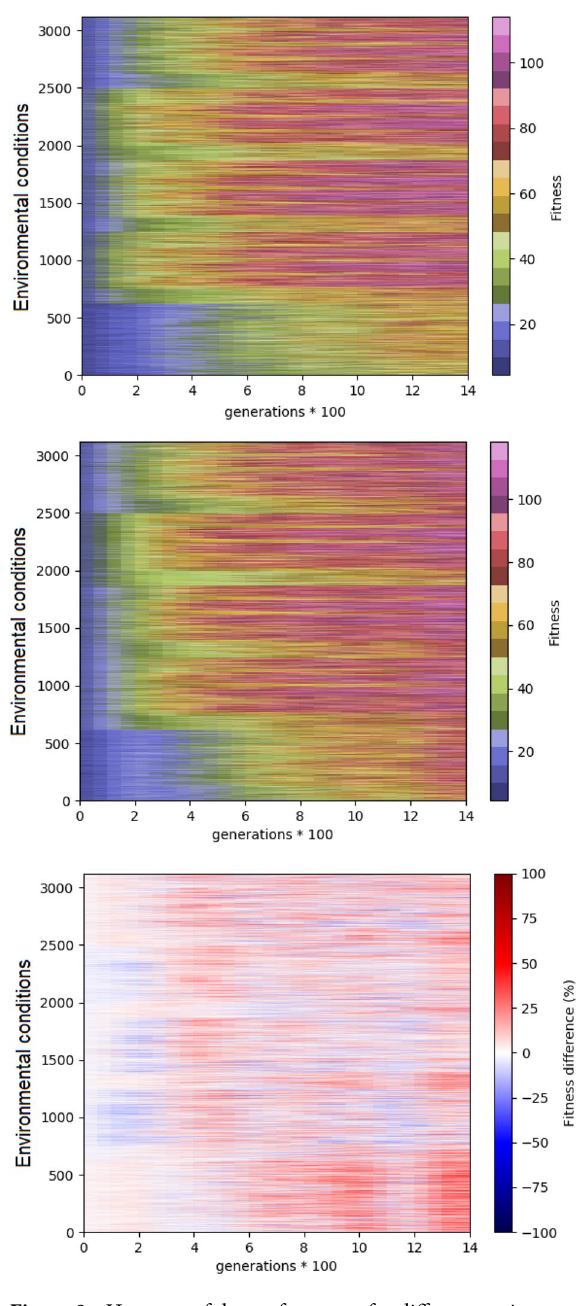
Figure 9. Heatmap of the performance for different environmental conditions during the evolutionary process. The vertical and horizontal axes indicate the environmental conditions and the generation. The top and central figures show the performance obtained in the experiment performed with the standard algorithm and with the curriculum learning algorithm with the cubic difficulty function. The bottom figure shows the difference between the performance obtained in the two conditions. Average results of 10 replications for each experimental condition. The figure is generated using python 3.6.7 https:// www. python. org/ downl